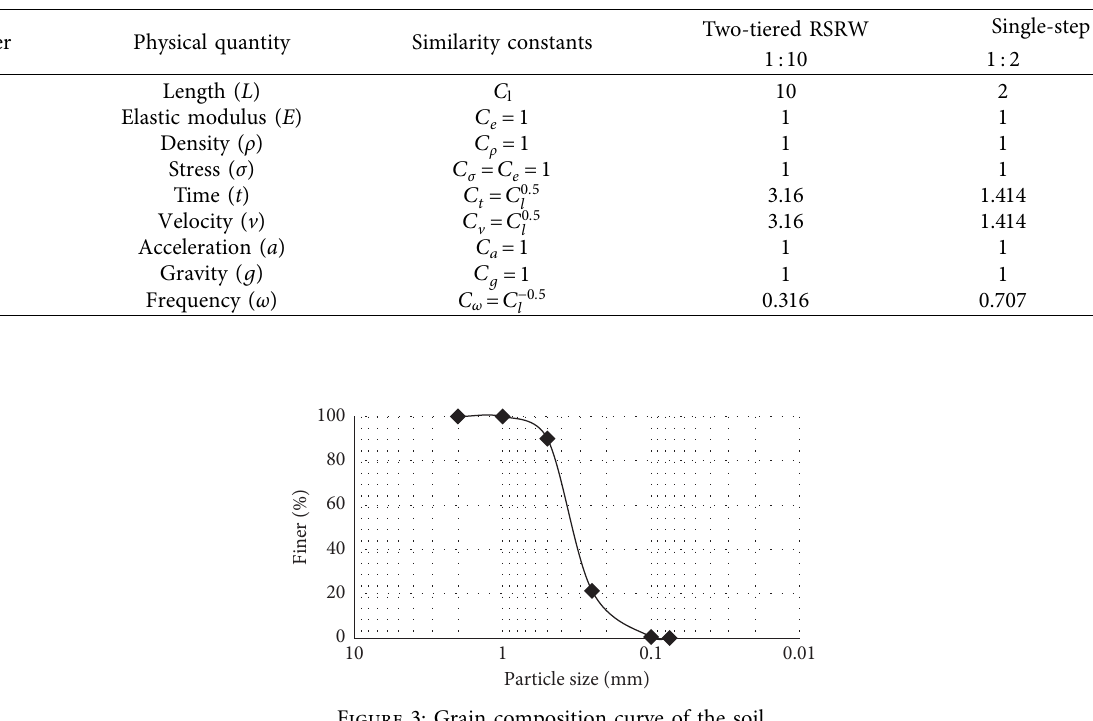
Table 1: Scaling factors in model test.